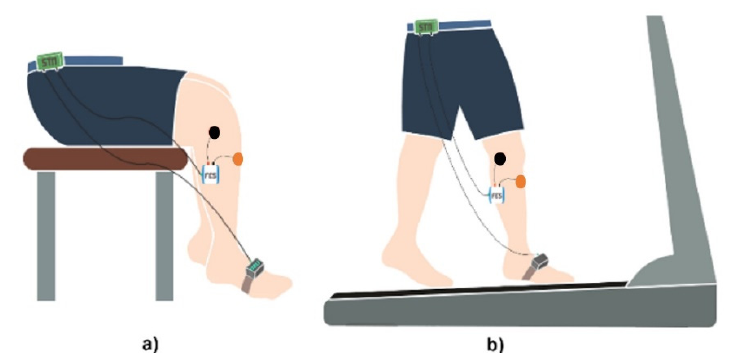
Figure 7. Validation setup: ( a ) Phase I protocol: The subject remained in a seated position, undergoing stimulation for the validation of the single feedforward NARXNN model, the single PD controller, and the feedback and feedforward strategy combing a PD with a NARXNN; ( b ) Phase II protocol: The subjects walked in a treadmill for three different speeds, undergoing stimulation to validate the feedback and feedforward strategy combing a PD with a NARXNN.